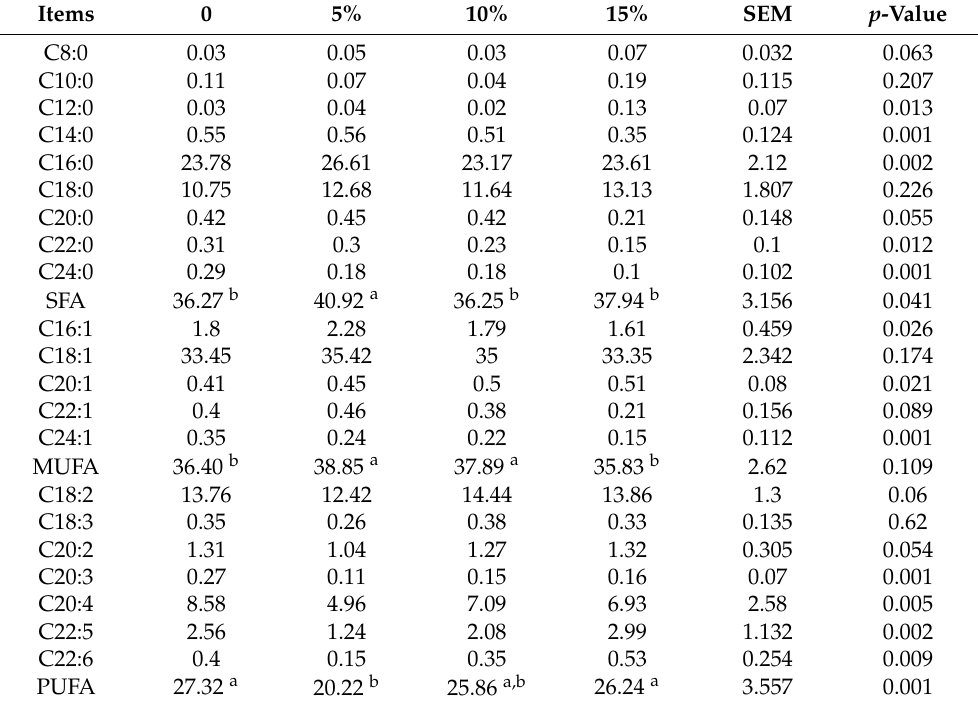
Table 7. The effect of adding fermented feed on the fatty acid composition of broiler breast muscle.